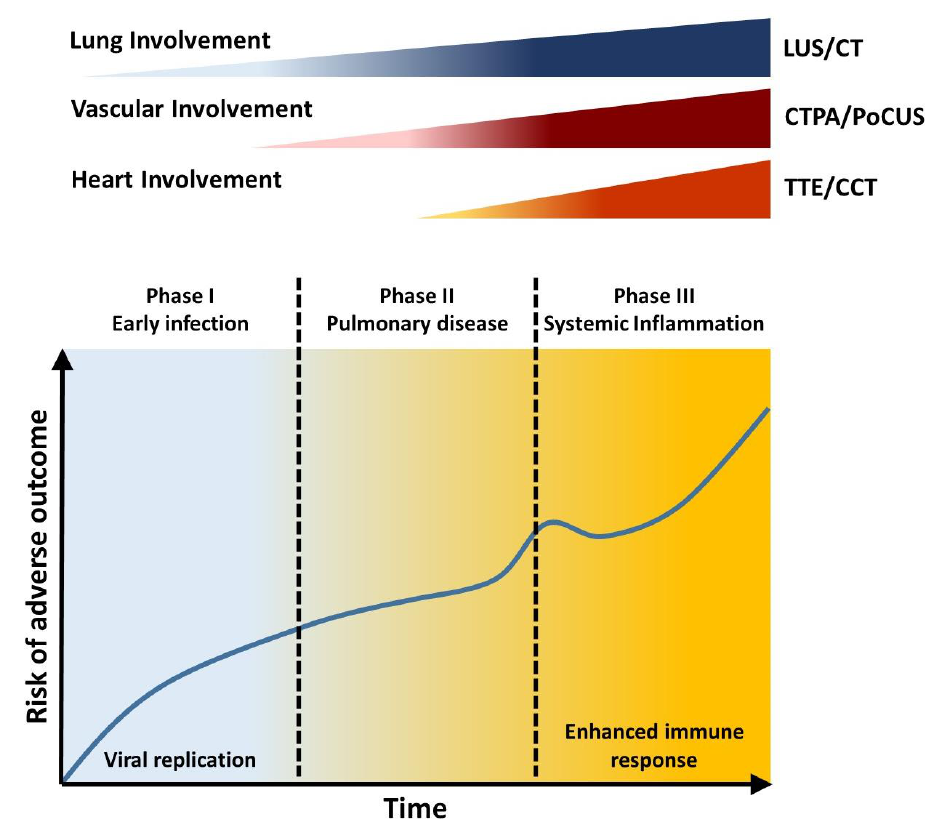
Figure 6. Viral replication and host immune response cooperate in disease progression. Through the three stages, different chest imaging modalities are useful to study the cardiovascular involvement. Transthoracic echocardiography (TTE) can identify left ventricle impairment as well as increased pulmonary hypertension and right ventricular dysfunction. Viral infection or to systemic inflammation can induce cardiovascular complications at different stages of the disease, inducing an increased risk for adverse outcome. To assess cardiovascular involvement specific multimodality imaging is required. CT: computed tomography; CTPA: computed tomography pulmonary arteriography; LUS: lung ultrasound; TTE: trans- thoracic echocardiography.